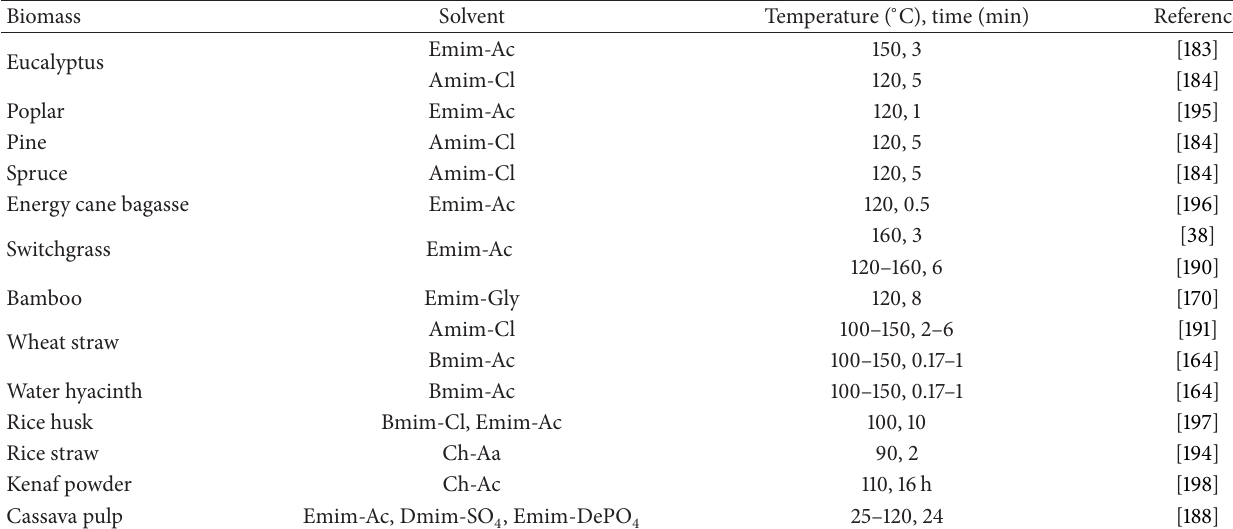
Table 1: Application of ILs to selected biomass